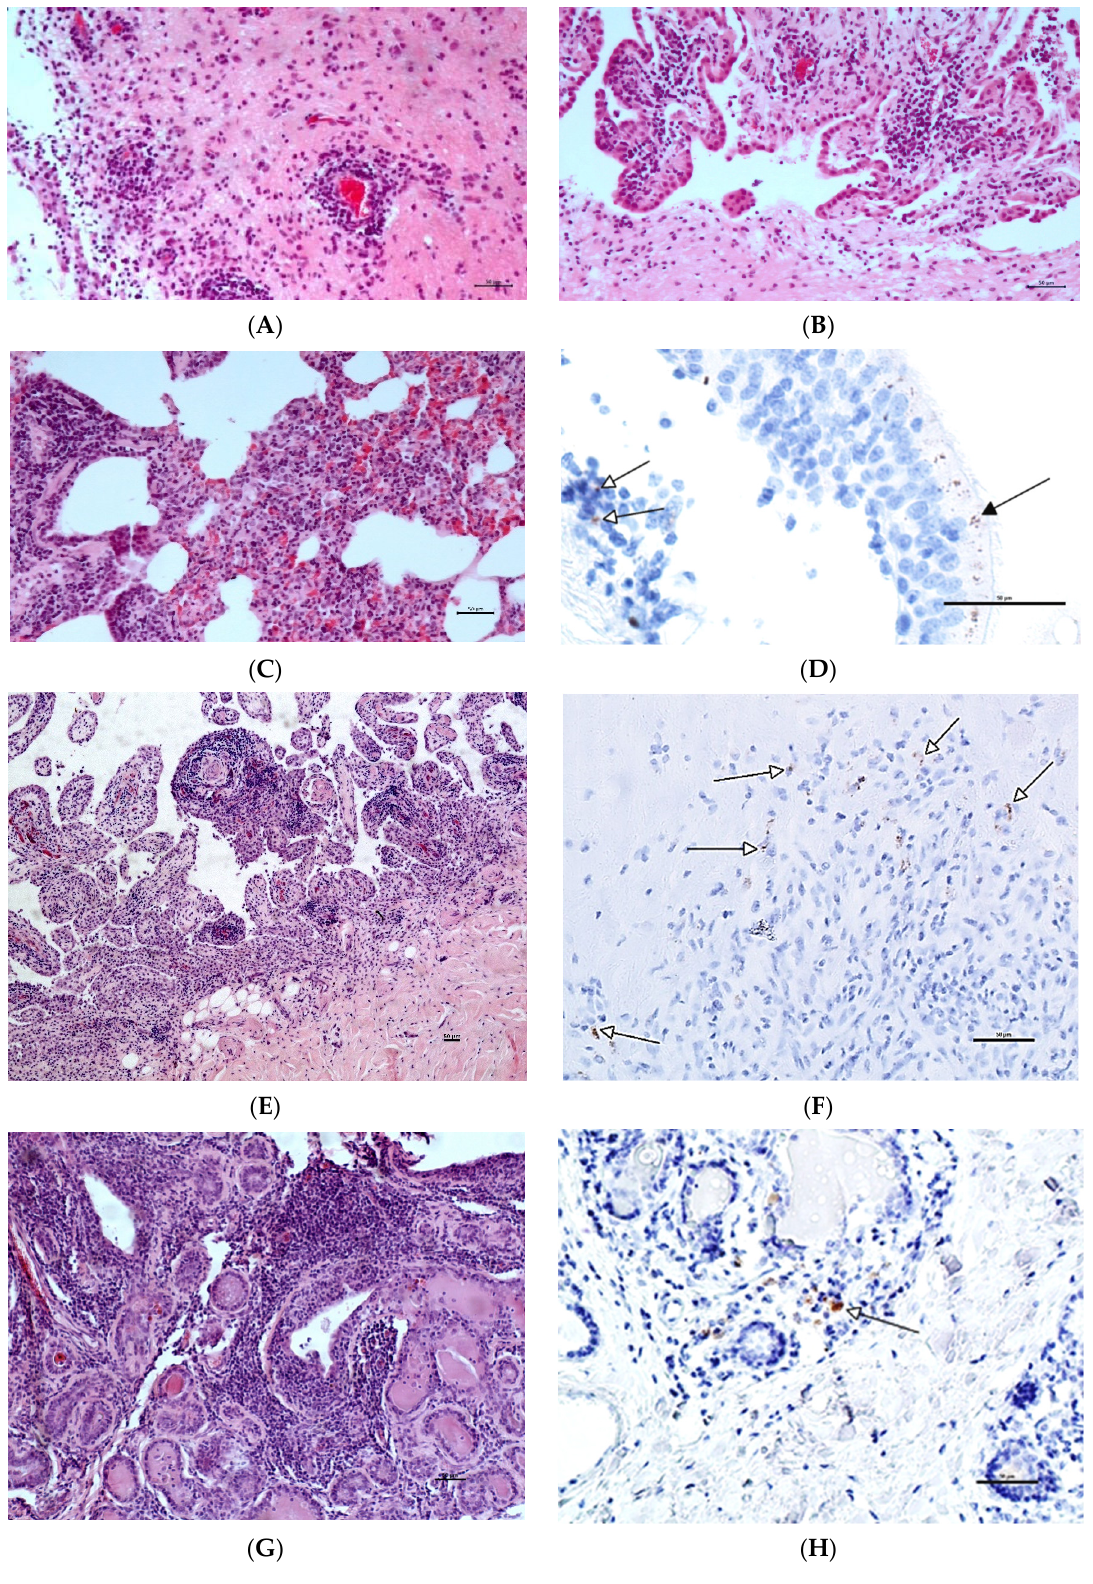
Figure 1. Example photomicrographs of tissue sections from the CAEV-infected goats. ( A – C , E , G )—Sections stained with hematoxylin and eosin (HE); ( D , F , H )—Immunohistochemical (IHC) labeling for CAEV p28 detection. ( A ) Brainstem, goat 5. Locally present mononuclear infiltrations around the blood vessel; ( B ) Choroid plexus, goat 5. Mononuclear infiltration within the choroid; ( C ) Lung, goat 7. Moderate interstitial pneumonia. The alveolar septa and peribronchial